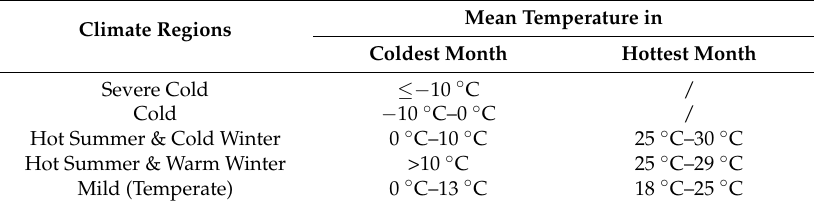
Table 2. Temperature characteristics for China in five different climate regions [28].